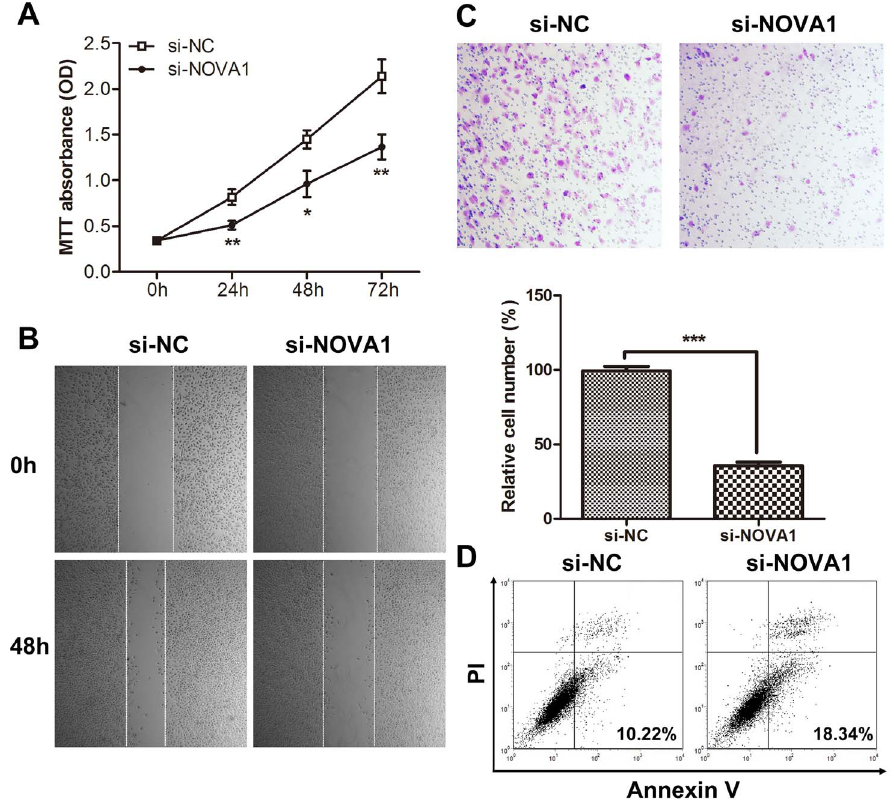
Figure 4. NOVA1 downregulation inhibited cell proliferation, migration and invasion and promoted apoptosis in vitro . (A) Downregulation of NOVA1 decreased cell growth (* p , 0.05, ** p , 0.01). The experiment was repeated three times. (B) Downregulation of NOVA1 decreased cell migration ability. (C) Downregulation of NOVA1 decreased cell invasion ability. The images shown are representative images from three independent experiments, and a statistical analysis was performed (mean 6 SD, *** p , 0.001). (D) Downregulation of NOVA1 promoted apoptosis.